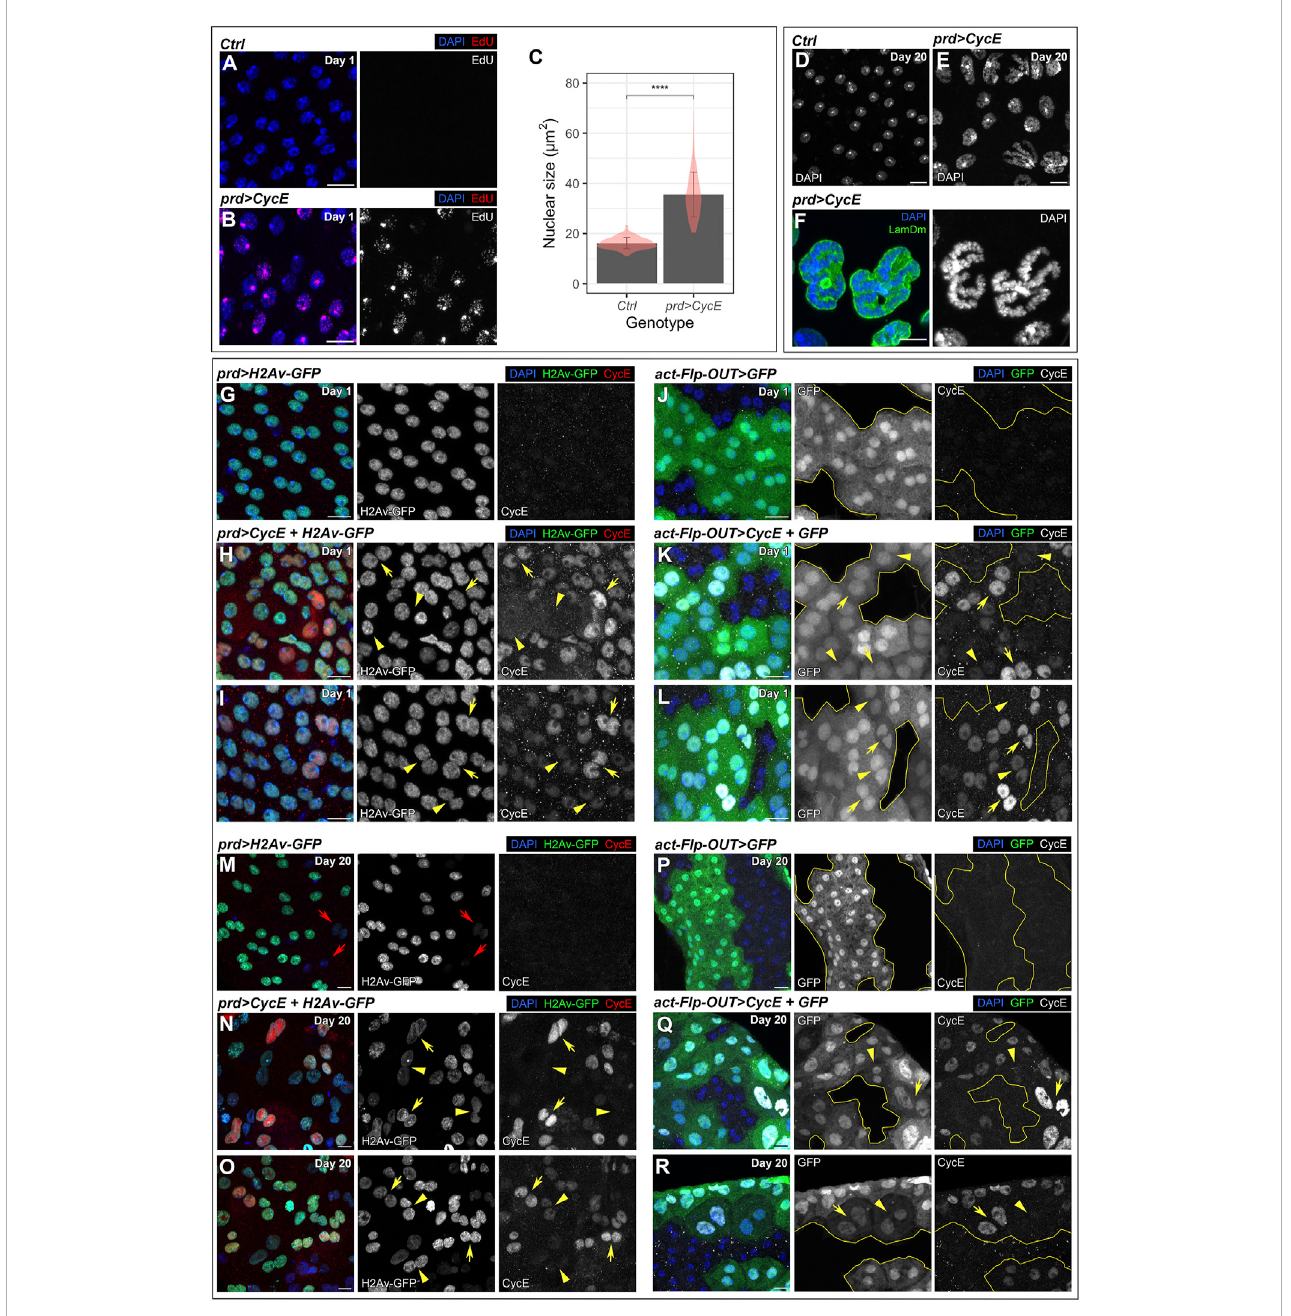
FIGURE 2 Cyclin E overexpressioninducesendoreplication. (A,B) Confocalimagesof control ( prd-Gal4/+ ) (A) and prd > CycE (B) accessory glands at day1 labeled with EdU. DAPI and EdU are shown in blue and red, respectively. Scale bars, 10 µm. (C) Quanti fi cation of nuclear size in control ( prd-Gal4/+ ) and prd > CycE accessory glands at day 1. Data shown are mean ± SD. The bars are overlayed with violin plots to showcase the distribution of the data. Statistical analysis was performedusingaMann-Whitneytestforunpaireddata.****, p < .0001. (D – E) Confocalimagesofcellsin20-day-oldcontrol( prd-Gal4/+ ) (D) and prd > CycE (E) accessoryglands.DAPIisshowningrays.Scalebars,10 µm. (F) Confocalimageofnucleiwithpolytenechromosomesin prd > CycE accessoryglands at day 20. DAPI and LamDm are shown in blue and green, respectively. Scale bar, 10 µm. (G – I) Confocal images of control ( prd > H2Av-GFP ) (G) and prd > CycE + H2Av-GFP (H,I) glands at day 1 stained with anti-CycE. In (H,I) , yellow arrowheads point to cells with absent or low Cyclin E levels in the nucleus, whereasyellowarrowspointtocellswithhighlevelsofCyclinEinthenucleus.DAPI,H2Av-GFPandCycEareshowninblue,green,andred,respectively.Note that the Gal80ts system was used in this experiment. Scale bars, 10 µm. (J – L) Confocal images of control ( act-Flp-OUT > GFP ) (J) and act-Flp-OUT > CycE + GFP (K,L) at day 1 stained with anti-CycE. Gal4-expressing cells can be identi fi ed by GFP, and the borders between GFP-positive and GFP-negative cells are outlined in yellow. In (K,L) , yellow arrowheads point to cells with absent or low Cyclin E levels in the nucleus, whereas yellow arrows point to cells with high levels of Cyclin E in the nucleus. DAPI, GFP and CycE are shown in blue, green, and grays, respectively. Scale bars, 10 µm. (M – O) Confocal images of control ( prd > H2Av-GFP ) (M) and prd > CycE + H2Av-GFP (N,O) glands at day 20 stained with anti-CycE. In (M) , red arrows point to cells with very low H2Av-GFP expression, possibly due to a lower expression of the Gal4 driver. In (N,O) , yellow arrowheads point to cells with absent or low Cyclin E levels in the